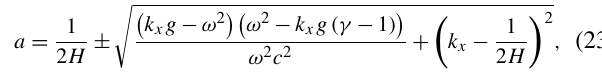
Figure 1. Dispersion dependencies ω = f (k x ) : (1) boundaries be- tween acoustic and gravity regions for freely propagating waves √ k x g (upper solid (dashed lines); (2) evanescent modes: ω = √ k x g(γ − 1 ) (lower solid curve), ω = N (thin hor- curve) and ω = izontal line), and ω = k x c (thin sloping straight